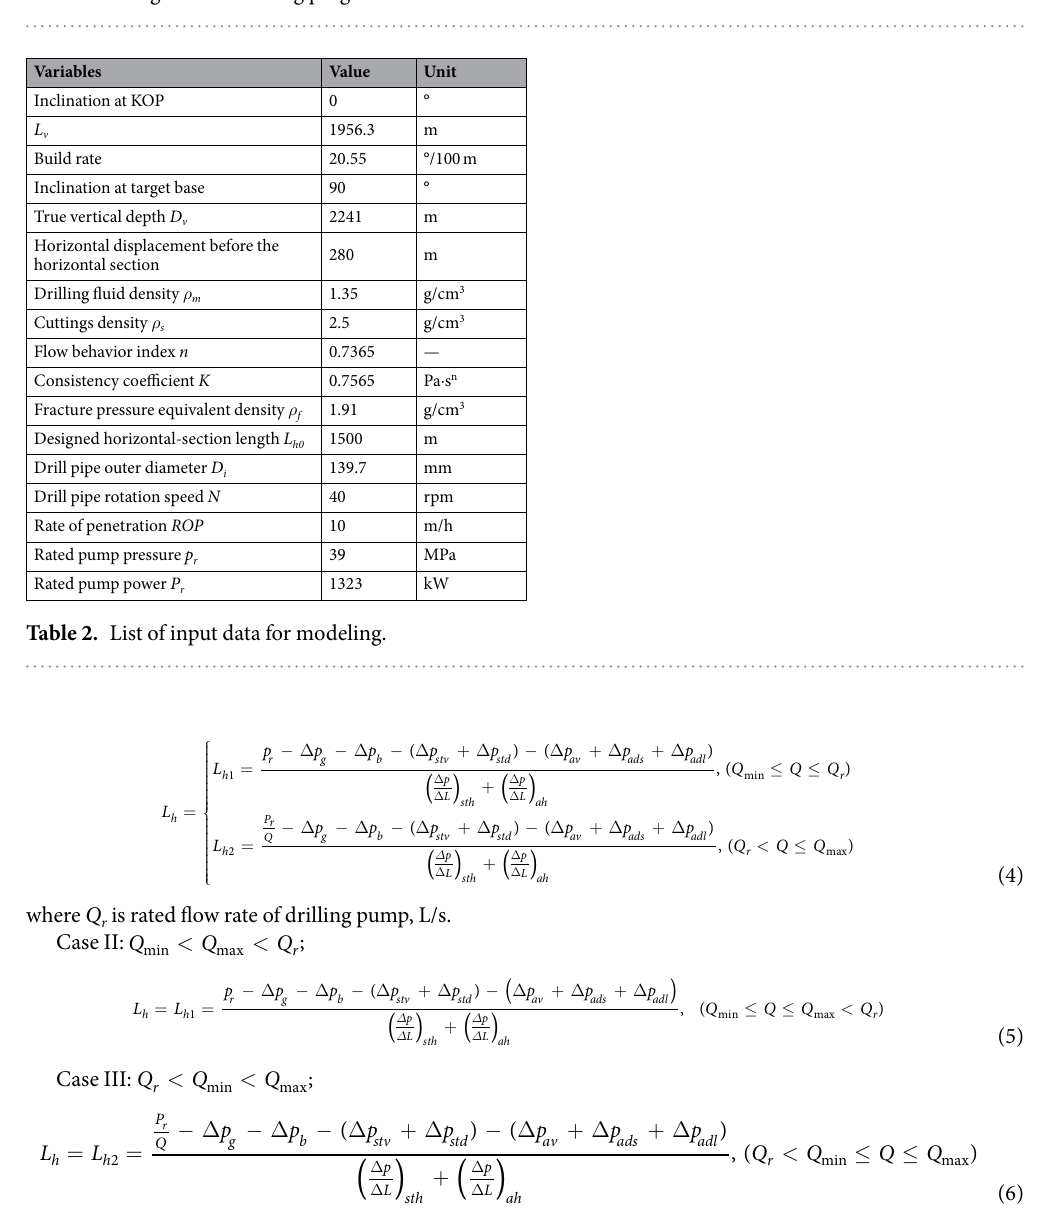
Table 1. Design table of casing program.